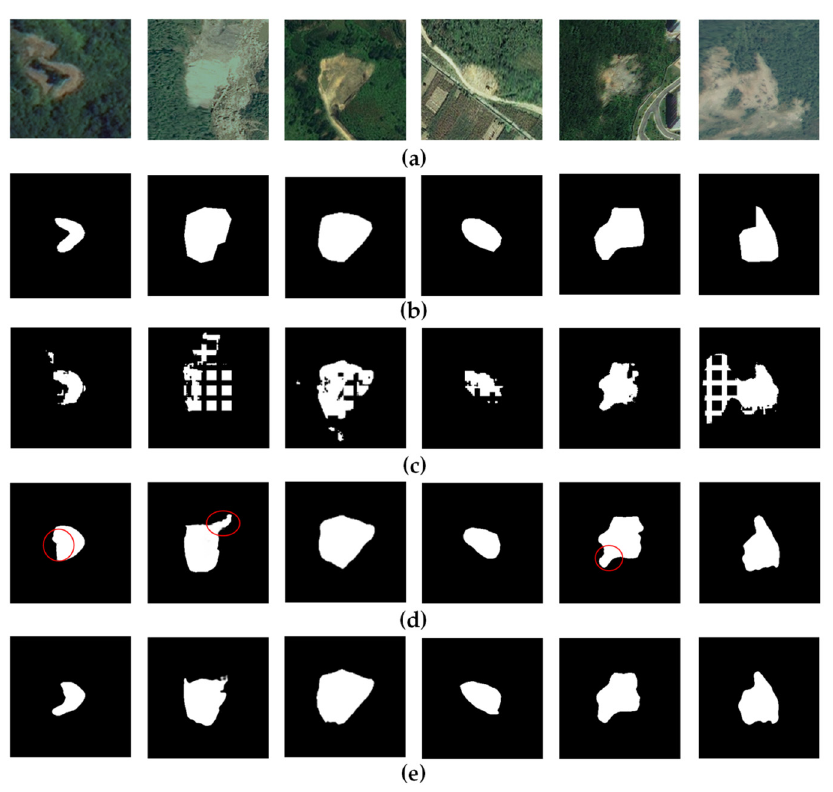
Figure 8. Examples of landslide extraction using DeepLabv3+ and the proposed network. White color denotes the region of landslide, and black color denotes the image background. ( a ) is the RGB images, and ( b ) is the ground-truth landslide boundaries corresponding to ( a ). ( c – e ) are the experimental results obtained using DeepLabv3+, the proposed network with single and multisource data, respectively. Red circle is used to highlight the comparative region.